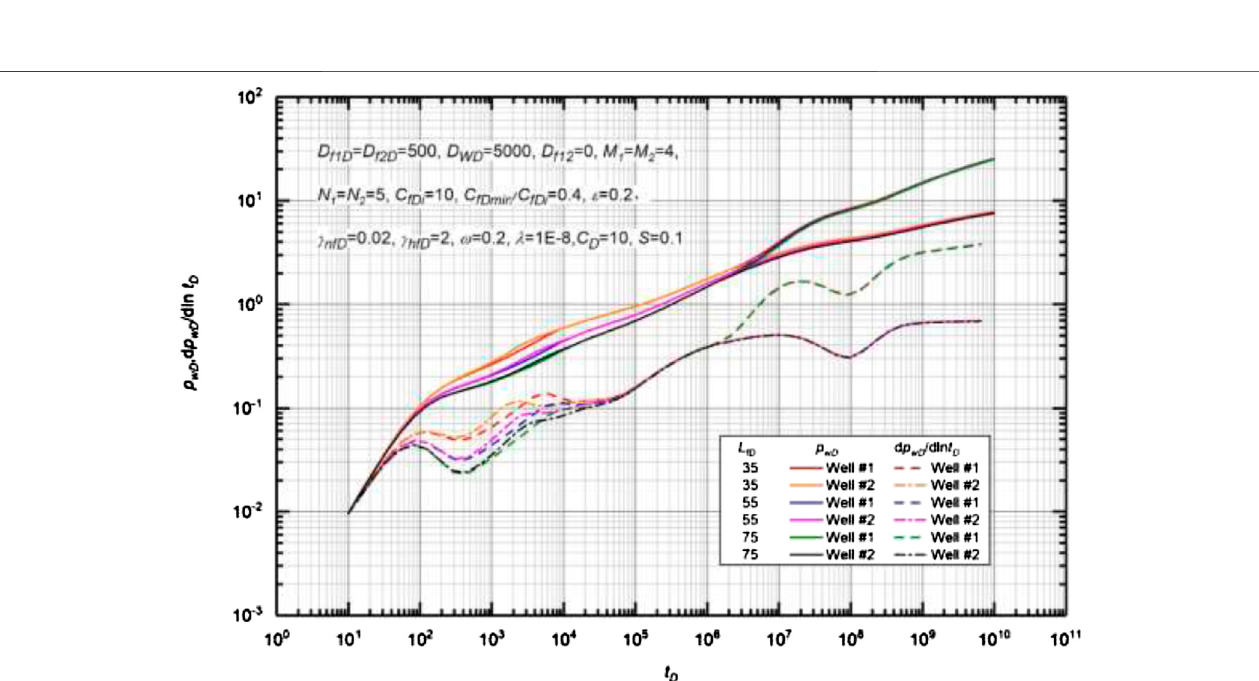
FIGURE 11 | Effect of HF length on the transient pressure for MWPMF.